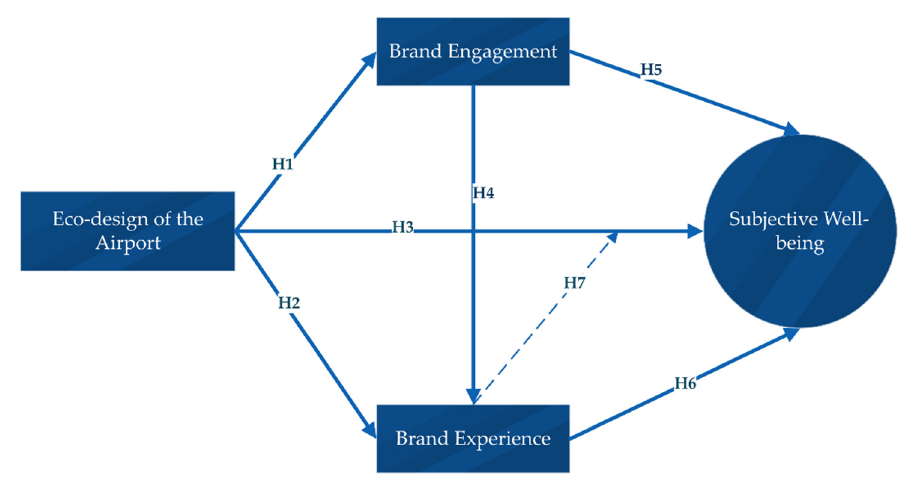
Figure 1. The hypothesized framework of the current study.